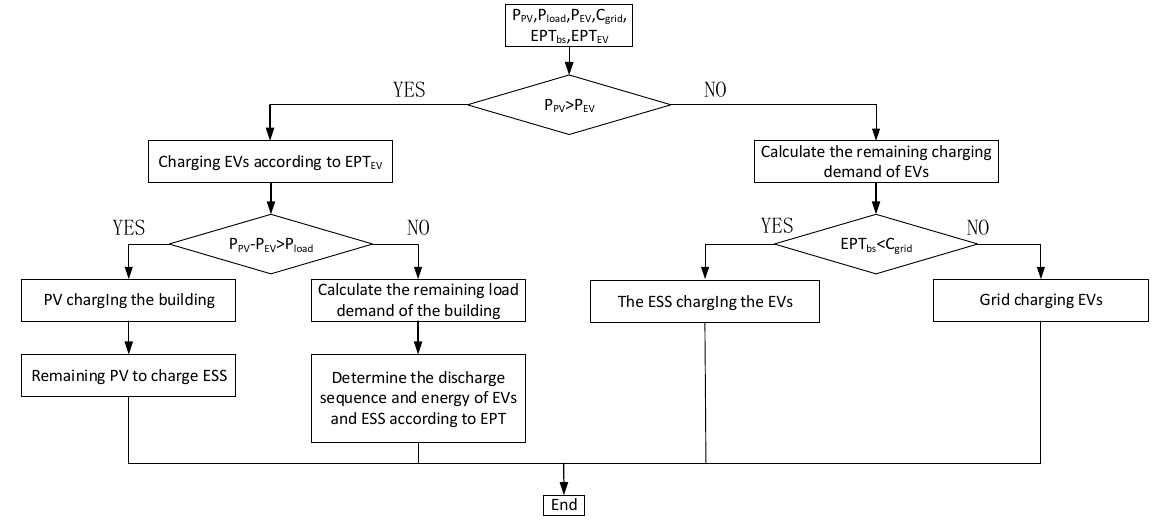
Figure 3. The control mechanism of the proposed control strategy.